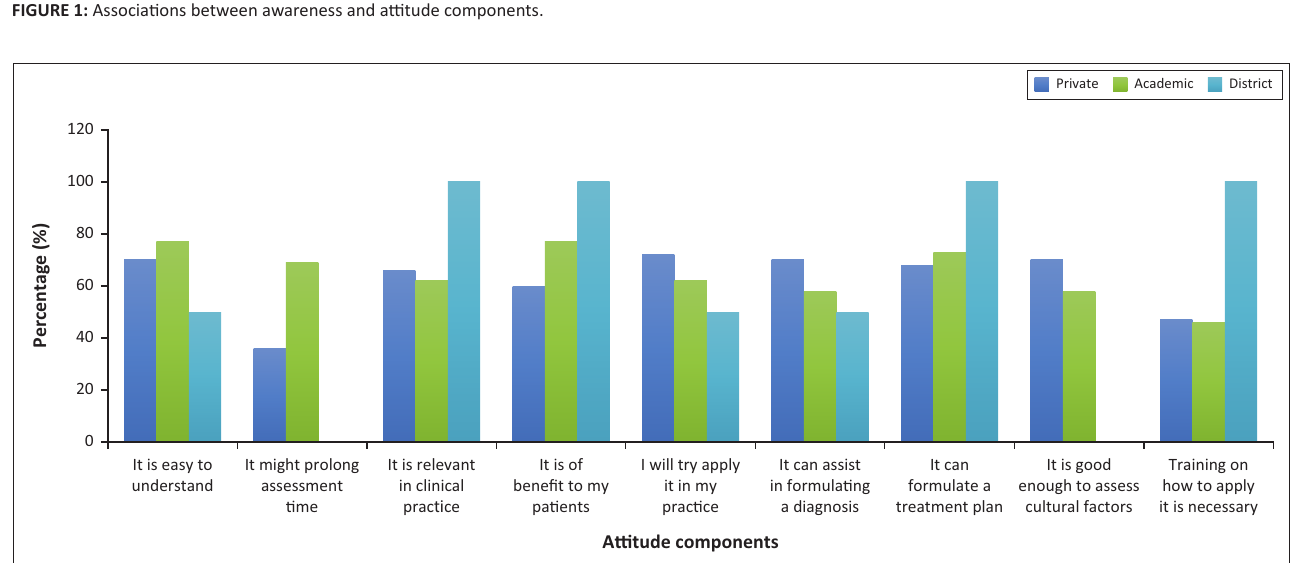
FIG URE 2: Attitude responses according to area of